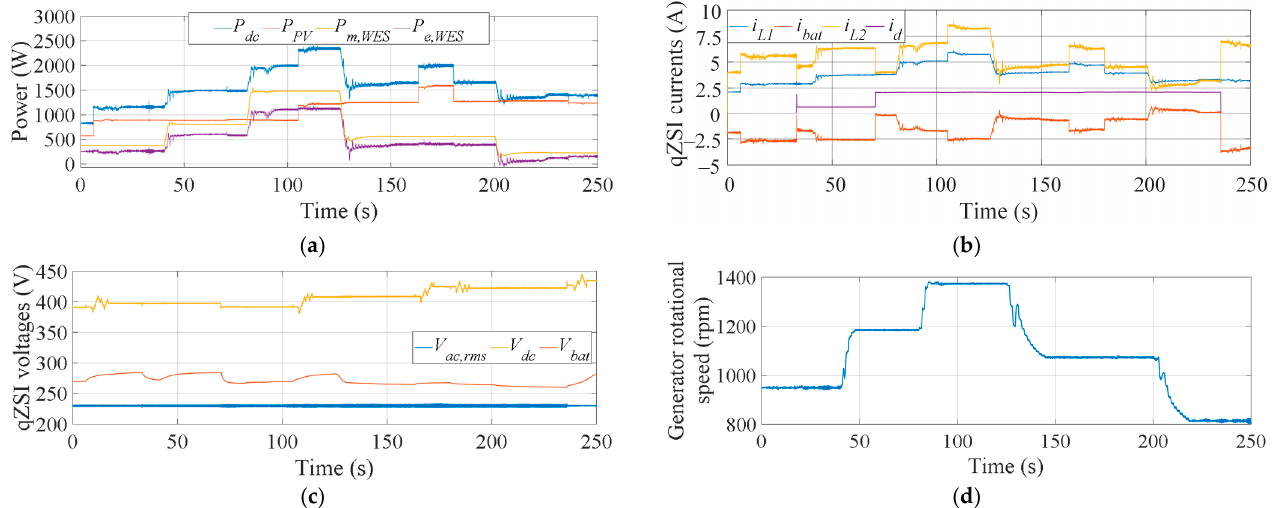
Figure 15. Dynamic responses during the island operation experiment: ( a ) electrical power and WT mechanical power; ( b ) qZSI currents; ( c ) qZSI voltages; ( d ) generator rotational speed.